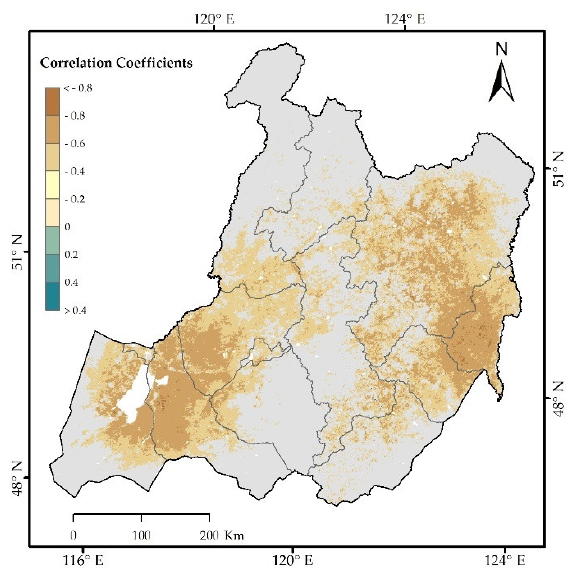
Figure 9 . Correlation coefficients between snow depth and the LST during the period of 2001–2018.